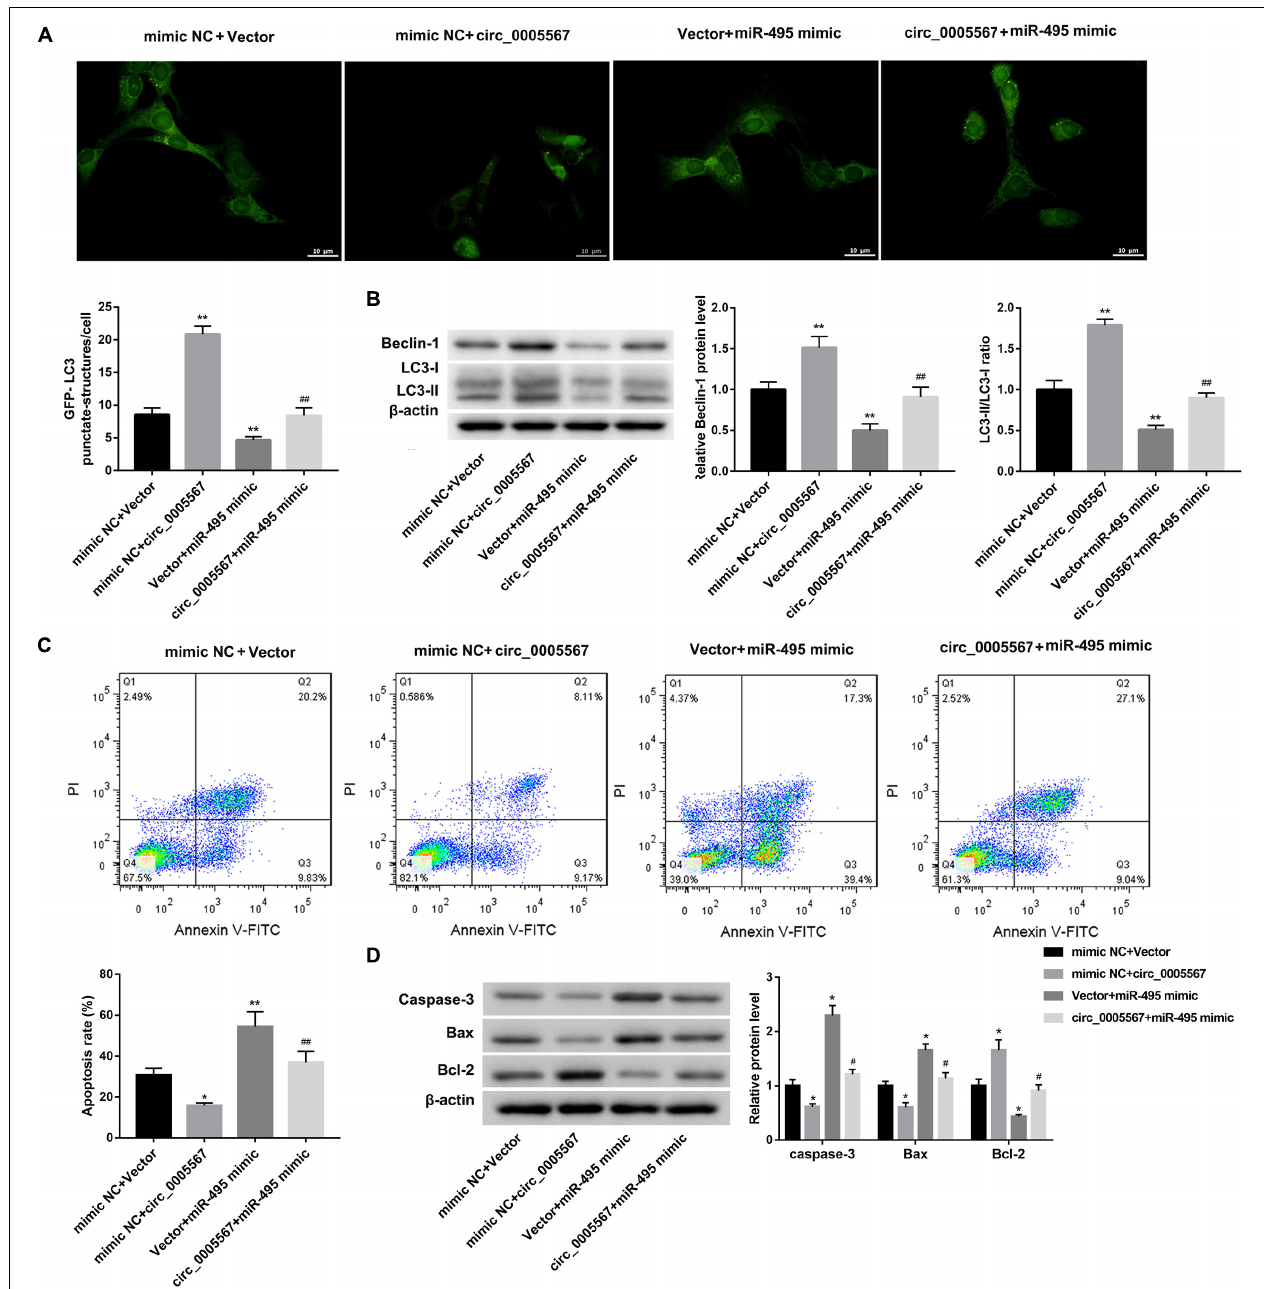
FIGURE 5 | Circ_0005567 promoted autophagy and inhibited chondrocyte apoptosis by inhibiting miR-495 expression. (A) Immunofluorescence results of chondrocytes transfected with GFP-LC3, (B) protein levels of Beclin-1 and LC3II/LC3-I examined by western blot, (C) cell apoptosis rate determined by flow cytometry after Annexin V-FITC/PI staining, and (D) protein levels of caspase-3, Bax, and Bcl-2 examined by western blot in chondrocytes co-transfected with miR-495 mimic/mimic NC and circ_0005567 overexpression vector/empty vector in the presence of IL-1 β . The data are expressed as mean ± standard deviation from three independent experiments. * P < 0.05, ** P < 0.01, versus the mimic NC + Vector group; # P < 0.05, ## P < 0.01, versus the mimic NC + circ_0005567 or Vector + miR-495 mimic group.